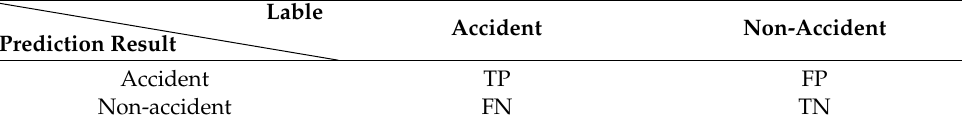
Table 3. Combination of labels and prediction results.